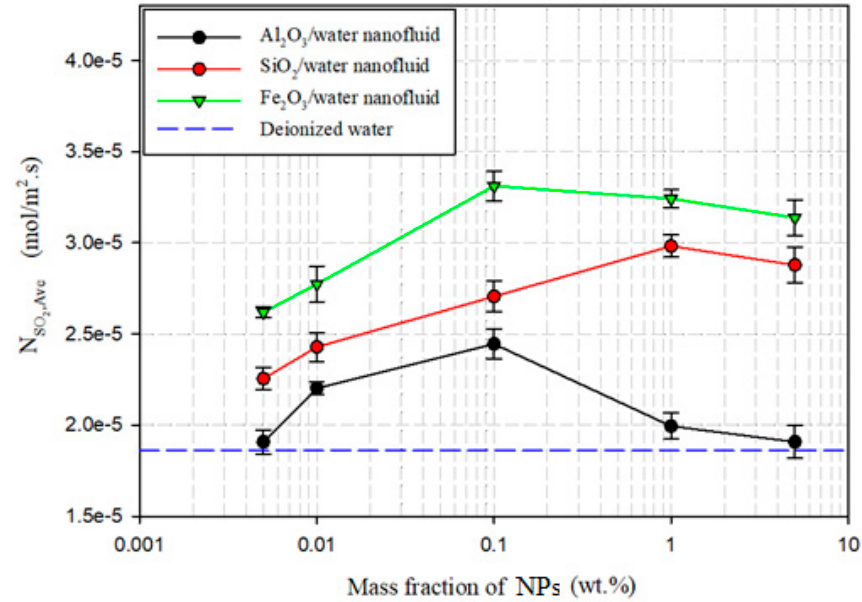
Figure 6. Average molar flux of SO 2 versus mass fraction of metal oxides nanoparticles.